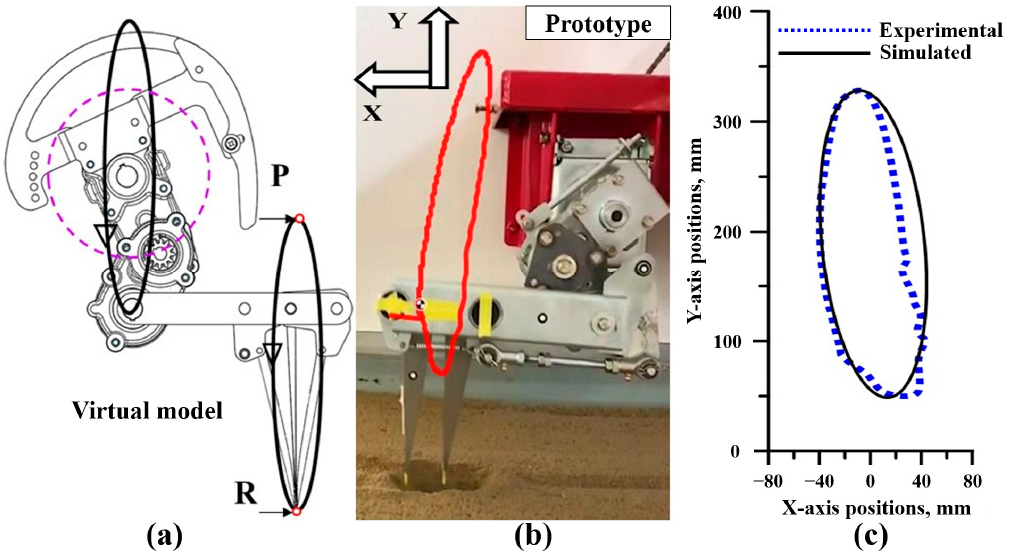
Figure 8. Working motion path trajectory of the planting mechanism at 60 rpm: ( a ) simulated, ( b ) experimental, and ( c ) comparison of the simulated and experimental results.